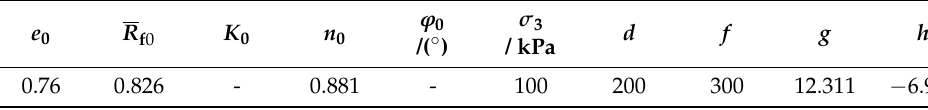
Table 6. Parameters of the simplified constitutive model.